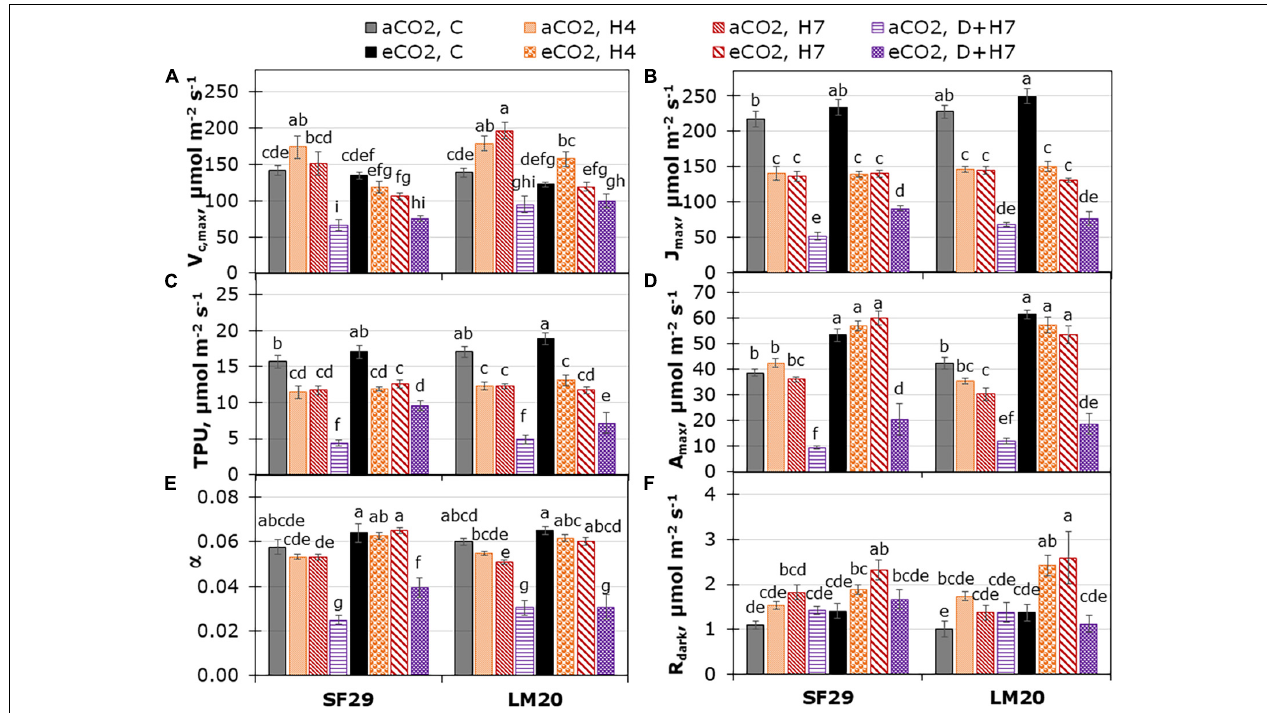
FIGURE 2 | Fitted parameters normalized at 25 ◦ C from CO 2 assimilation response curves; (A) Carboxylation rate by Rubisco (V c , max ), (B) rate of photosynthetic electron transport (J max ), (C) triose-phosphate utilization (TPU) and from light response curves; (D) maximum net CO 2 assimilation rate at light saturation (A max ), (E) apparent quantum yield of CO 2 assimilation ( α ) and (F) dark respiration rate (R dark ) in heat-sensitive (SF29) and heat-tolerant (LM20) genotypes grown under control conditions (C), heat stress at Day 4 (H4), at Day 7 (H7), and combined heat stress and drought at Day 7 (D + H7) at ambient CO 2 (aCO 2 ) or elevated CO 2 (eCO 2 ). The data represent mean values ± standard error (S.E.) ( n = 6–8). Different small letters indicate significant differences within variants according to Duncan’s test after ANOVA ( p <